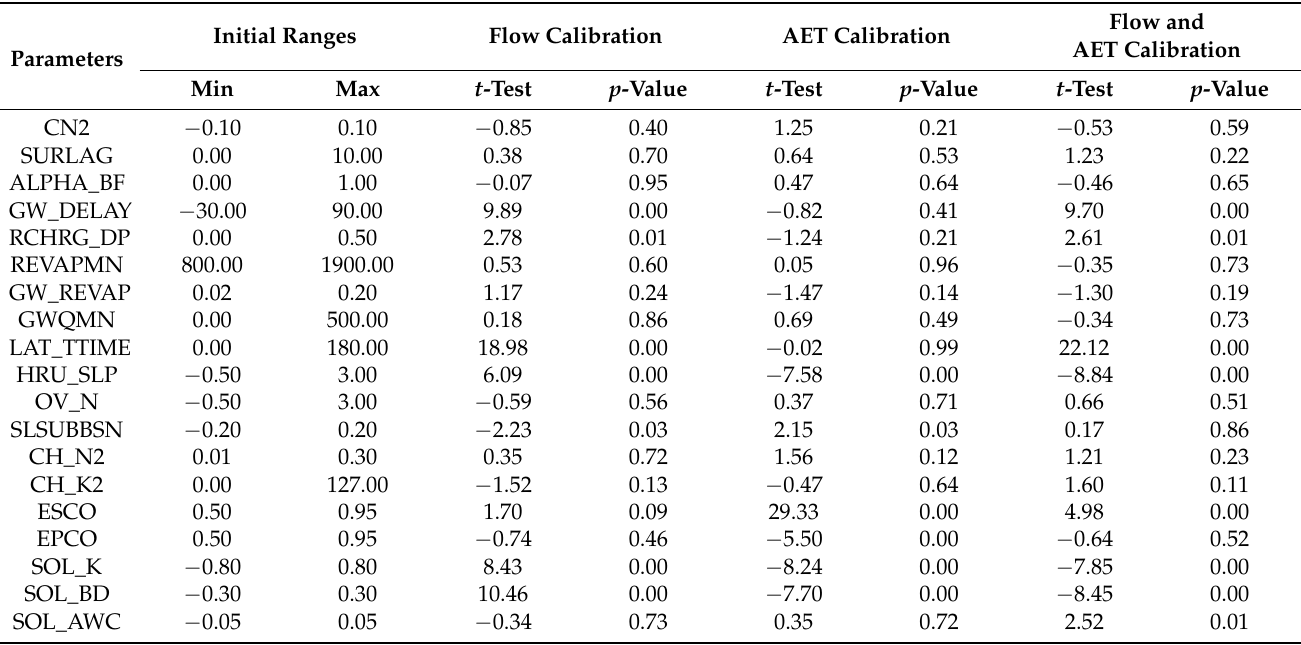
Table 2. SWAT calibrated parameters and their sensitivities for each calibration scenario. Numbers in bold indicate the parameters with the highest sensitivity ( p -value <